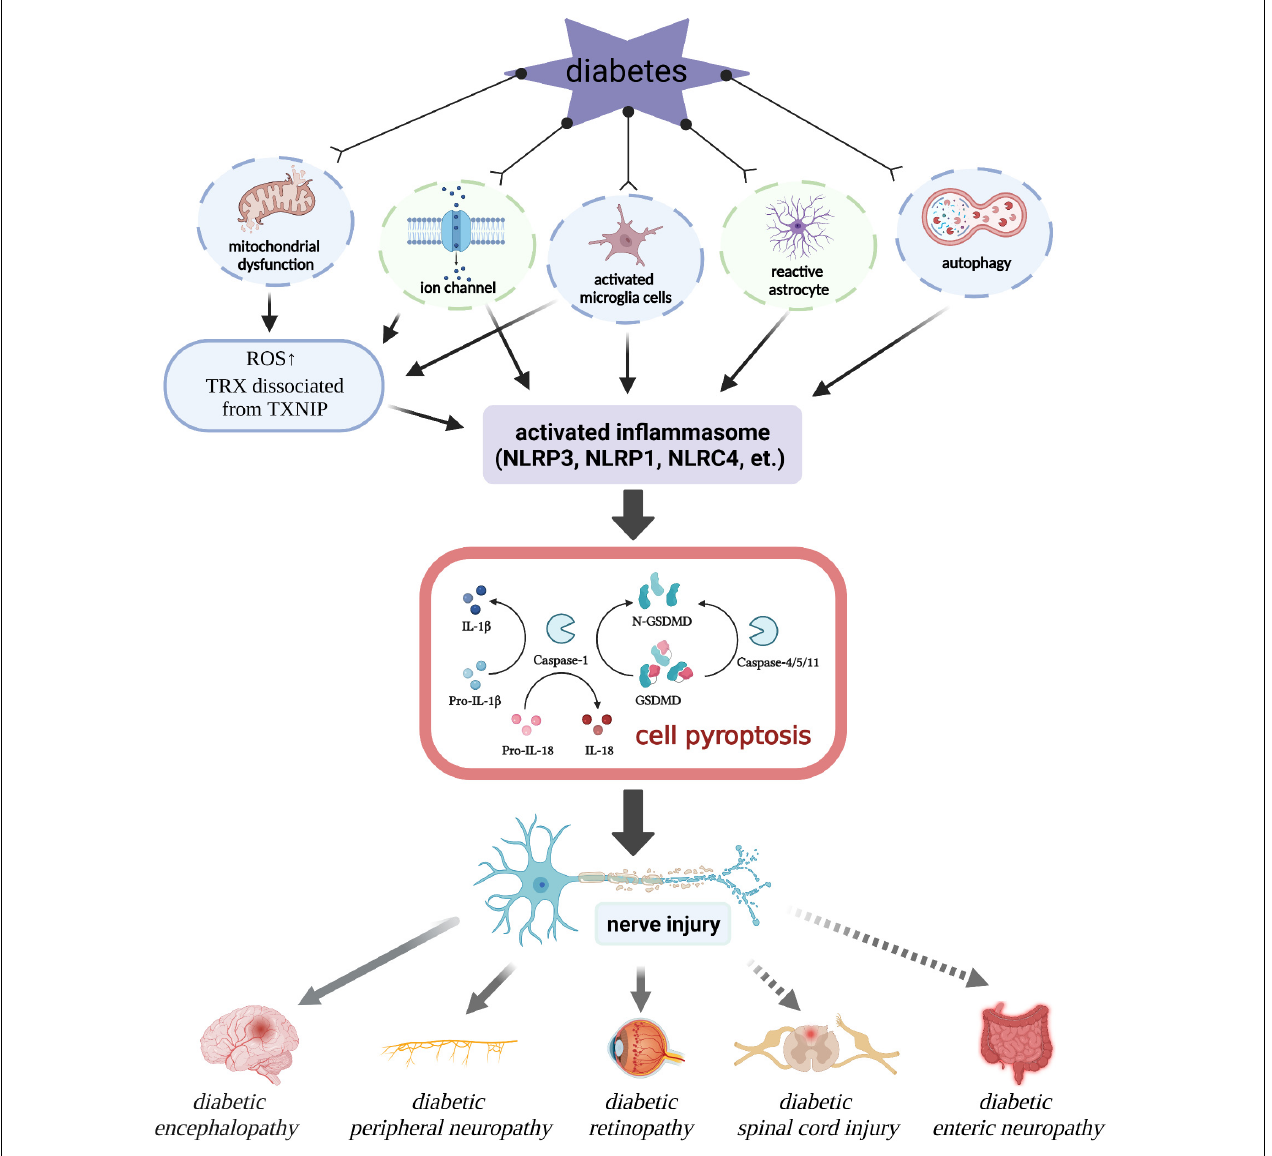
FIGURE 2 | Regulatory role of pyroptosis in diabetic neuropathy. ROS, reactive oxygen species; TRX, thioredoxin; TXNIP, thioredoxin-interacting